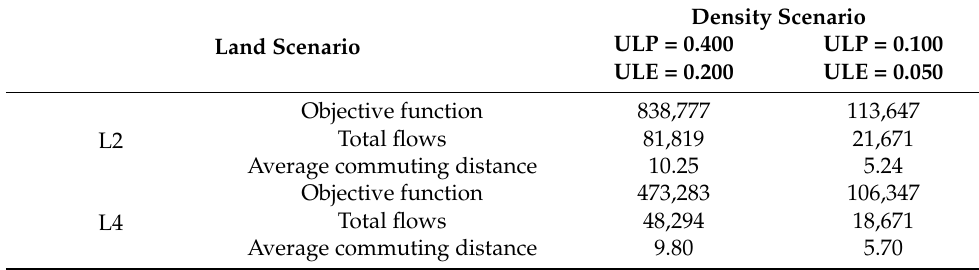
Table 12. Optimal Objective Function, Total Flow, and Average Commuting